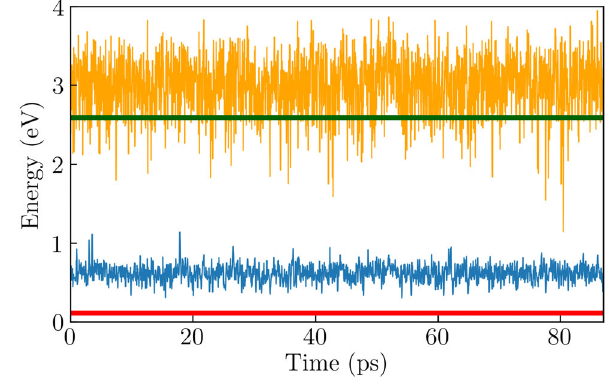
FIG. 4. Time series of the HOMO-LUMO (blue) and HOMO – 1-LUMO (orange) energy gaps. The horizontal red line indicates the thermal energy k B T . The horizontal green line is the average HOMO-LUMO gap for the stoichiometric K 32 Cl 32